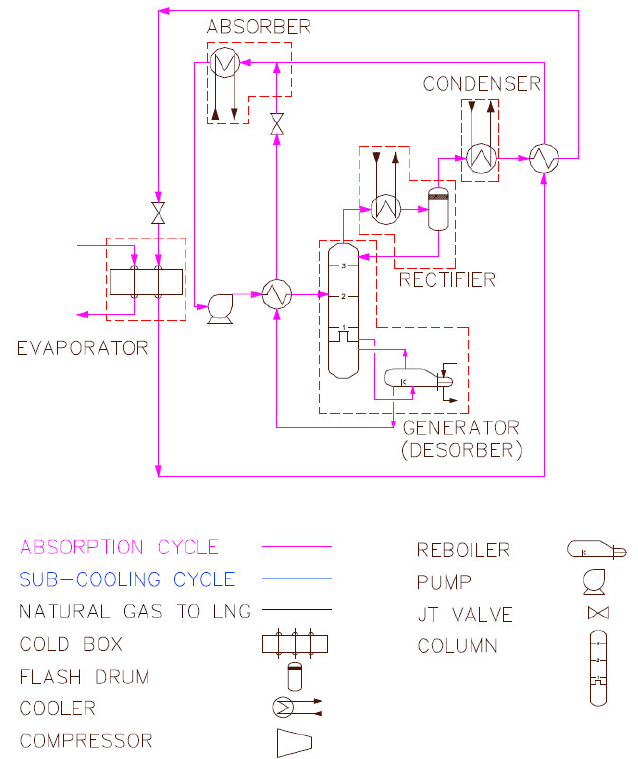
Figure 11. Schematic of NH 3 /H 2 O ARC simulated in Aspen HYSYS [50]. Reproduced with permis- sion from Elsevier (license number